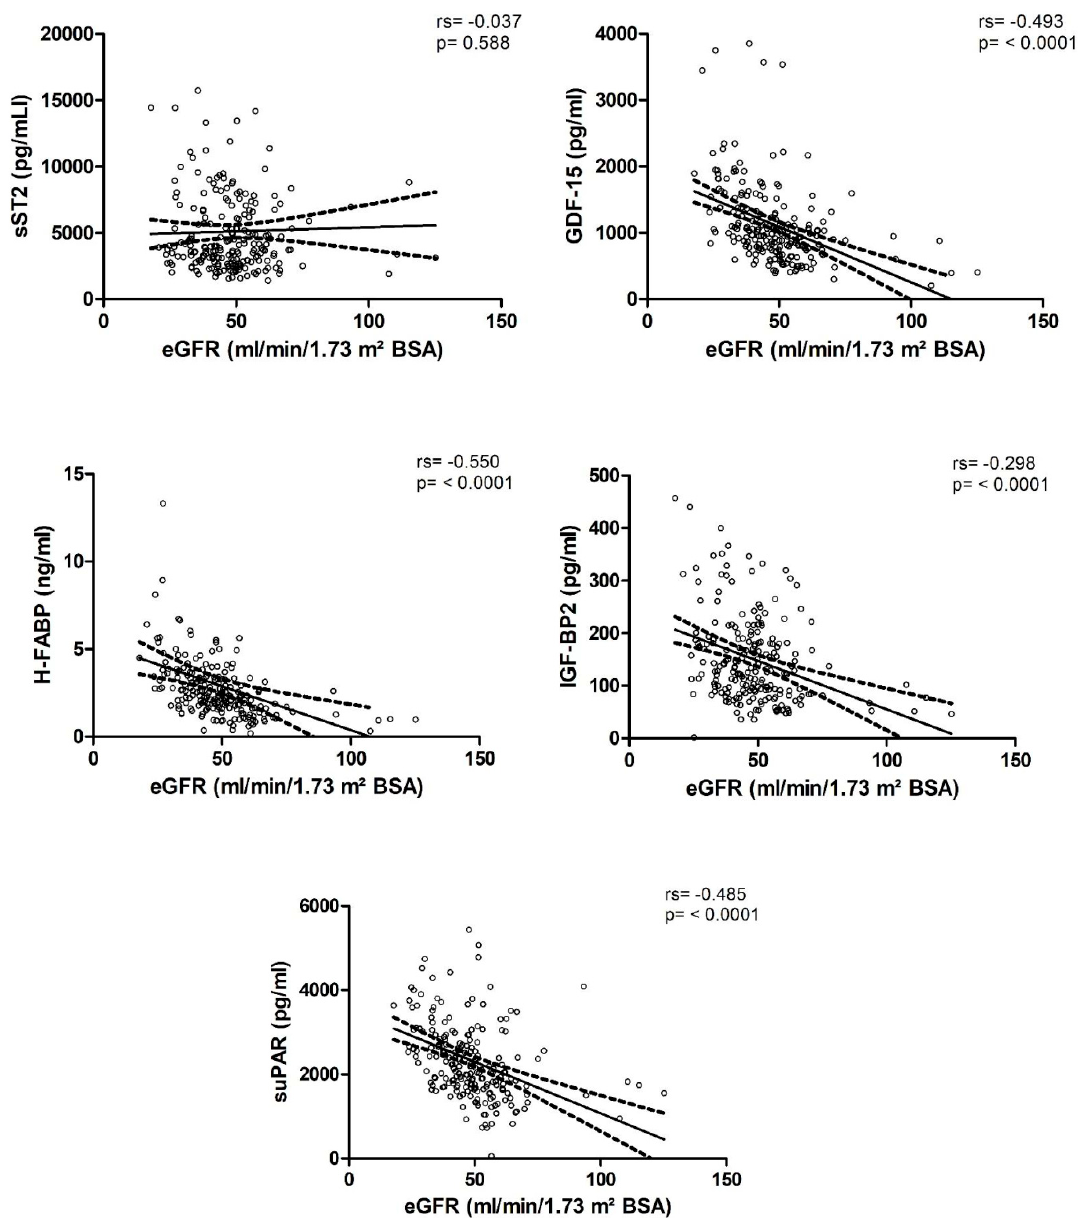
Figure 2. Visual representation of the correlation of biomarker concentrations with estimated glomerular filtration rate (eGFR).